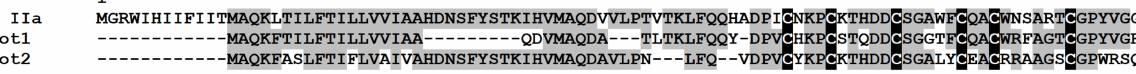
Figure 10. Multiple sequence alignment of S. lycopersicum knottin precursors and S. tuberosum metallocarboxypeptidase inhibitor precursor (mcpi) IIa (NP_001275048.1). Cysteine residues are shaded black, and identical amino acids are shaded